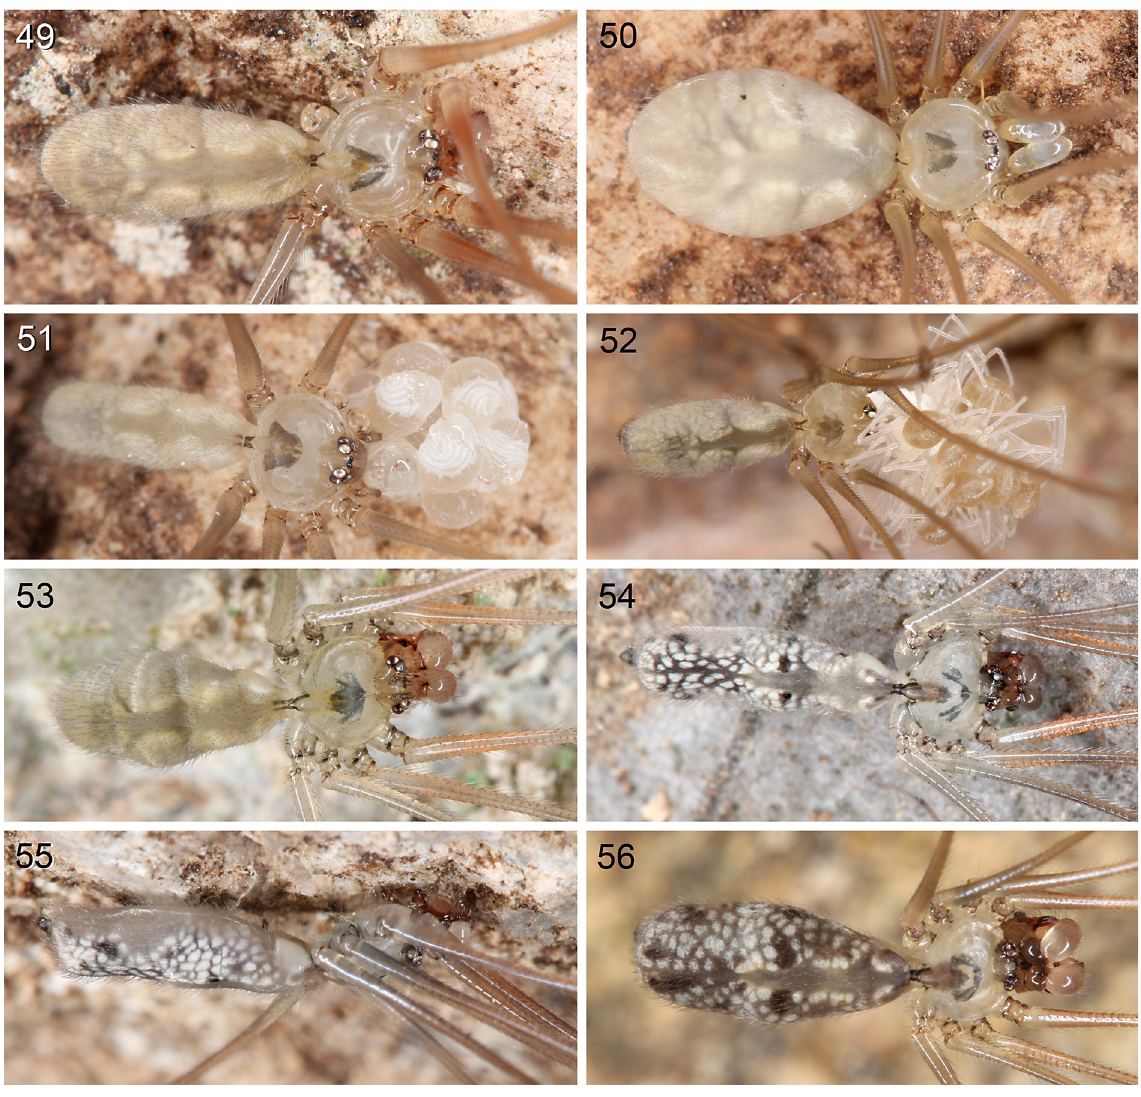
Figs 49–56. Live specimens, Pholcus kuhapimuk Huber, sp. nov. (49–51), Ph. khaolek Huber, sp. nov. (52–53), and Ph. sudhami Huber, 2011 (54–56). 49–51 . ♂, penultimate instar ♂, and ♀ with egg-sac from Wat Kuhapimuk, Thailand. 52–53 . ♀ with spiderlings and ♂ from Khao Lek, Thailand. 54–55 . ♂ from Tham Phraya Nakhon, Thailand. 56 . ♂ from Erawan,